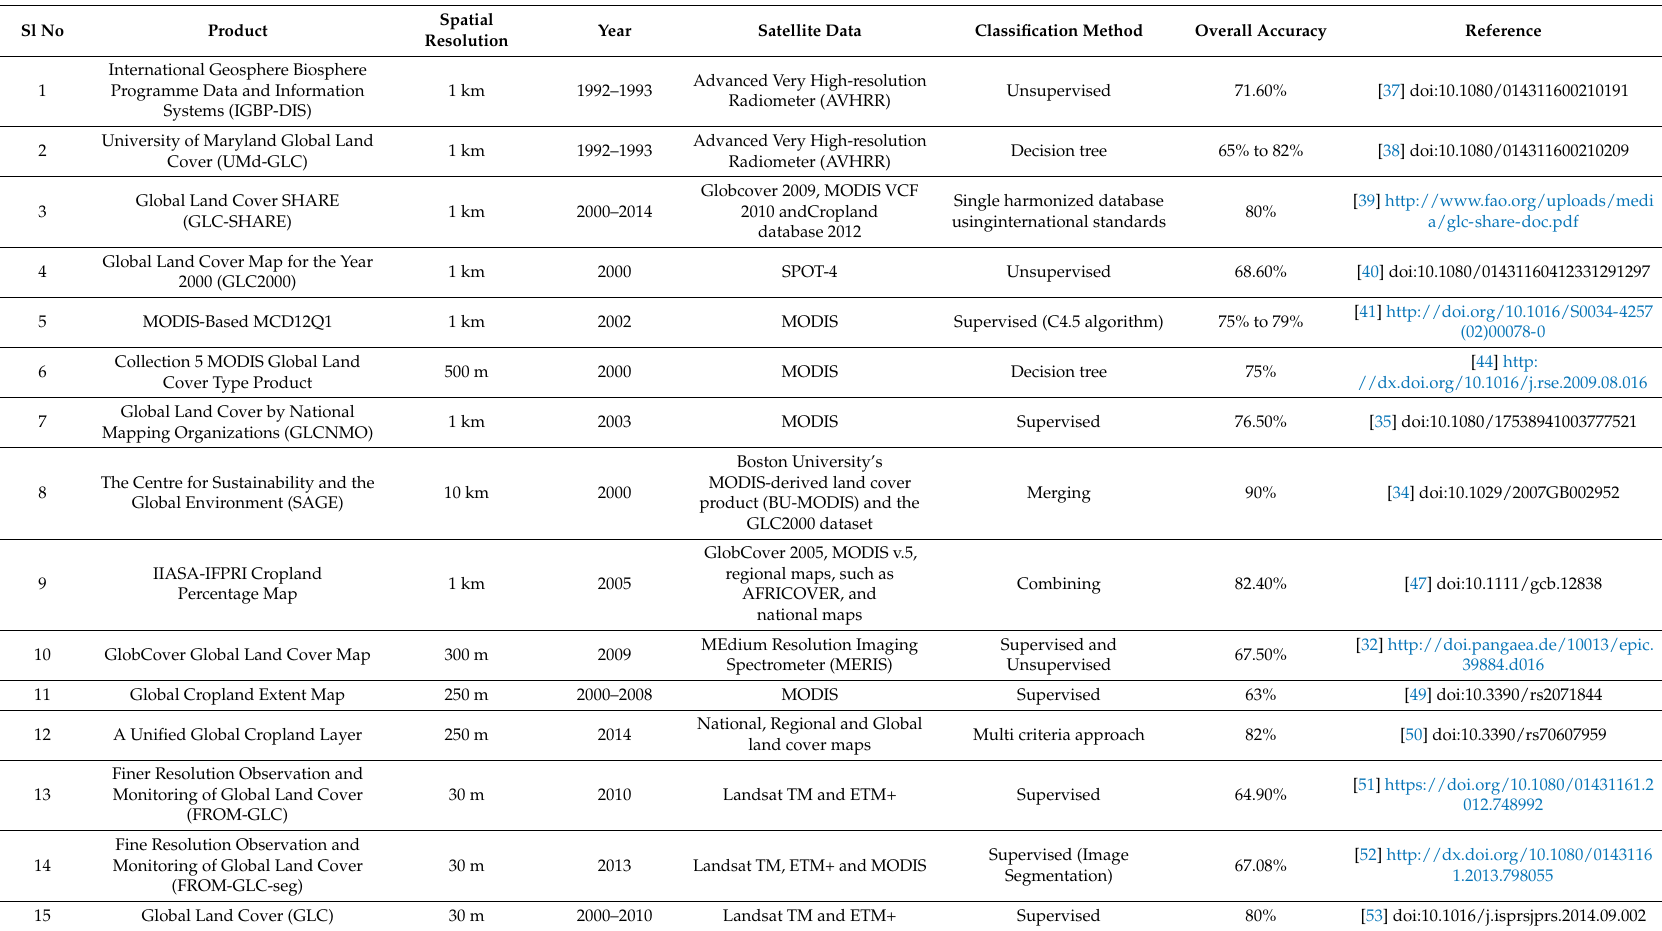
Table 2. Summary of the available global land cover and cropland